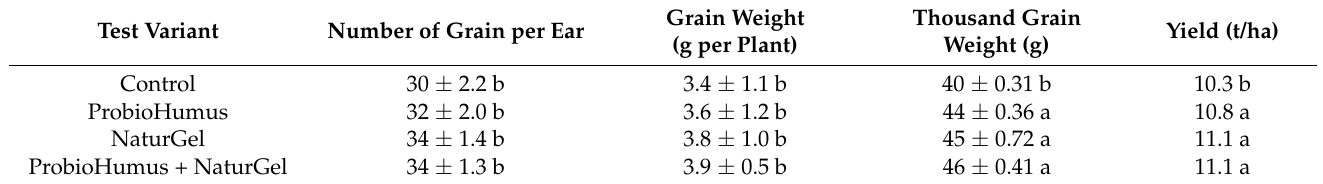
Table 4. Effect of probiotic preparations on wheat grain yield formation at full maturity stage.